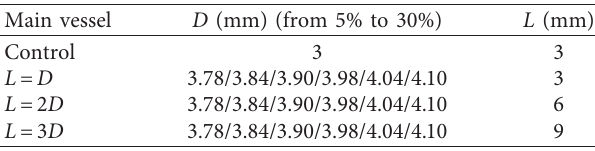
Table 2: Geometry parameters of side branches. Side